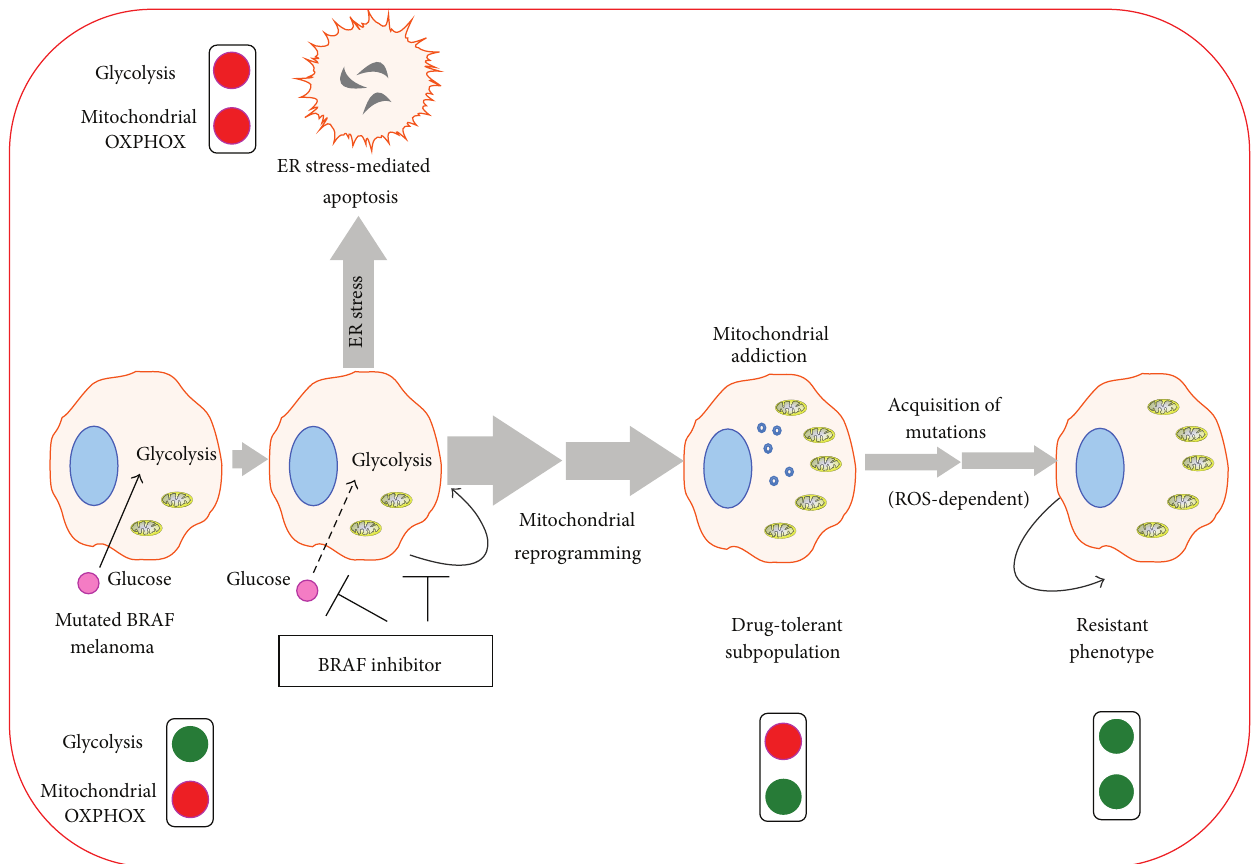
Figure 4: Hypothetical diagram depicting roles of mitochondrial reprogramming in BRAF mutated cells when exposed to BRAF inhibitors (see text for details). Mutated BRAF melanoma mainly relies on aerobic glycolysis. Upon BRAFi exposure, glucose uptake and glycolysis are inhibited leading to ER stress and cell death by apoptosis and consequent energetic collapse (inhibition of both glycolysis and mitochondrial OXPHOS). However, there remains a subpopulation of BRAFi-tolerant cells. These cells reprogram the metabolism towards mitochondrial oxidation in orderto surviveand consequently thisBRAFi-tolerant subpopulation of cells becomes addicted to mitochondria. Thesesurviving cells are prone to accumulating subsequent mutations (potentially induced by mitochondrial ROS overproduction) leading to the onset of a resistant phenotype characterized by aerobic glycolysis associated with high levels of mitochondrial activity (red blot: inhibition, green blot: